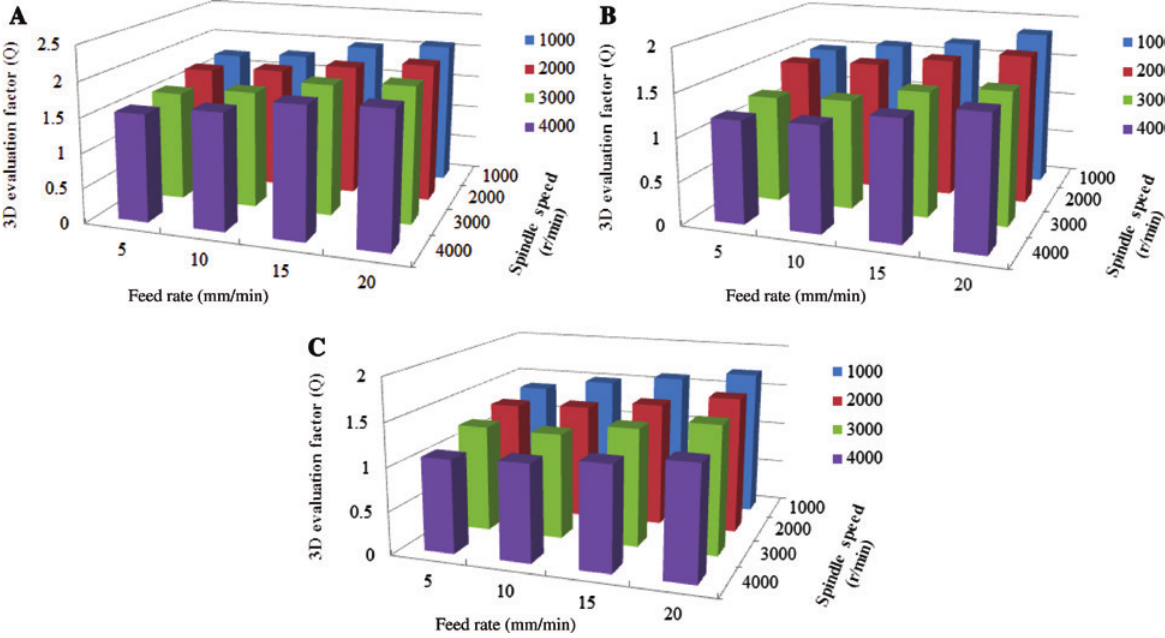
Figure 5: The typical interrelation of the drilling quality with the spindle speed and the feed rate for three different drills. (A) Carbide drill, (B) DLC drill, and (C) PCD drill.